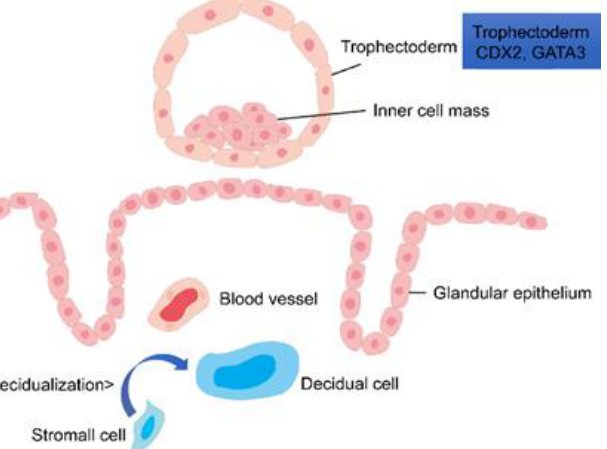
Figure 1. Placental development immediately before implantation and involved genes in the trophectoderm.